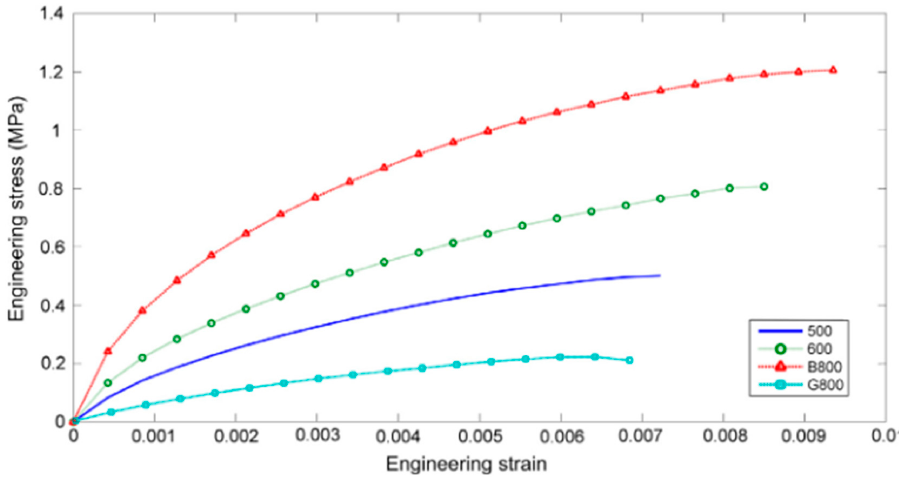
Figure 1. Uniaxial tension test of stress vs. strain of the four variants of TDM [17]